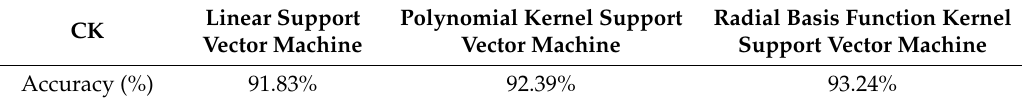
Table 9. Comparison of recognition results with a simple classifier and multi-classifiers based on